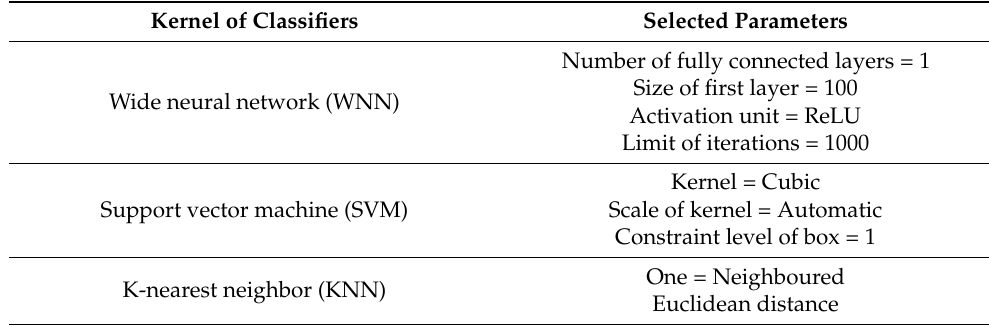
Table 2. Description of